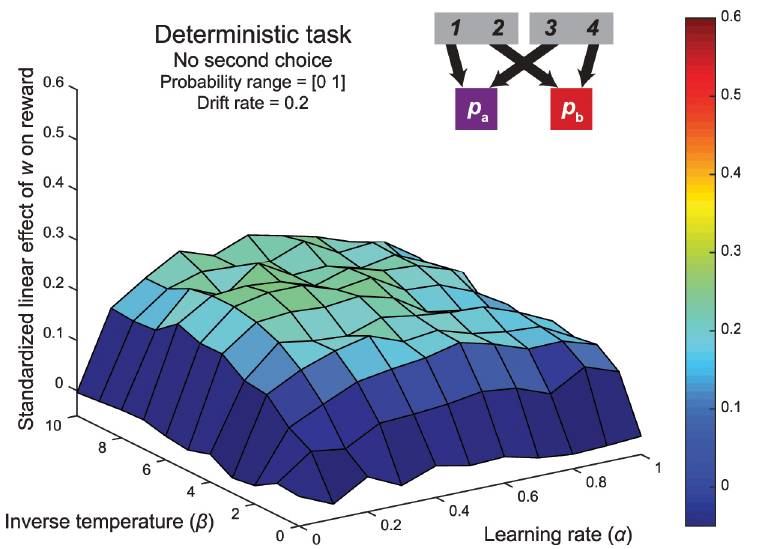
Fig 9. The influence of reducing the number of second-stage action. Because of the deterministic transitions, model-based choices in the Doll two-step task always result in the desired state outcome. Combined with increased distinguishability and increased drift rate in the reward probabilities, this task results in a substantial increase in the relationship between planning and